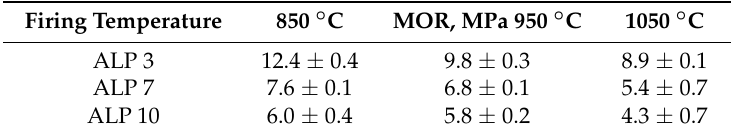
Table 3. Modulus of rupture (MOR) (MPa) for bending strength test of samples.